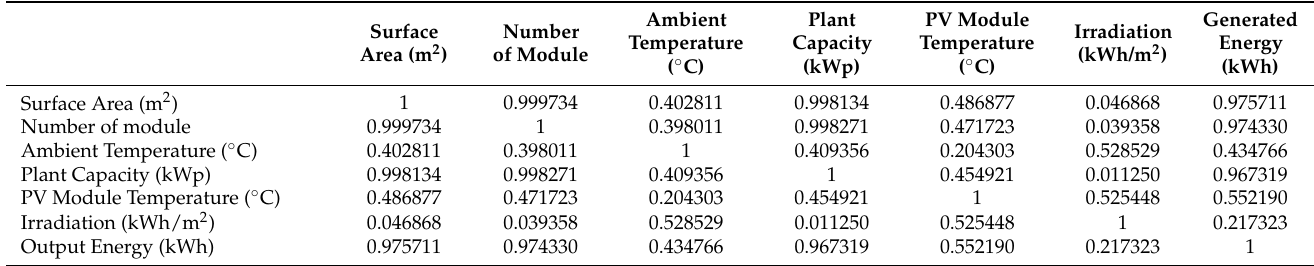
Table 3. Correlation of Input and